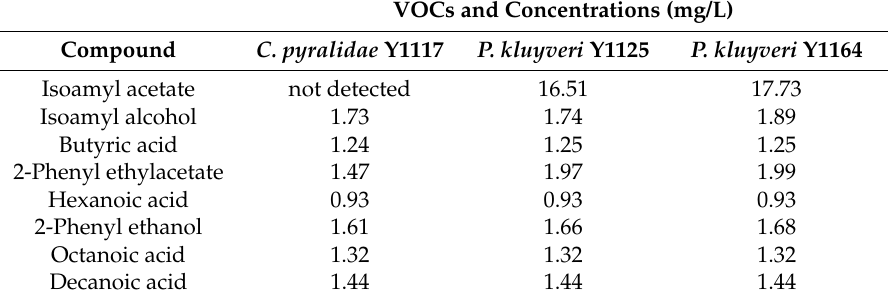
Table 3. List of quantified volatile organic compounds (VOCs) identified to be produced by Candida pyralidae Y1117, Pichia kluyveri Y1125 and P. kluyveri Y1164 when grape pomace extract is used as fermentation